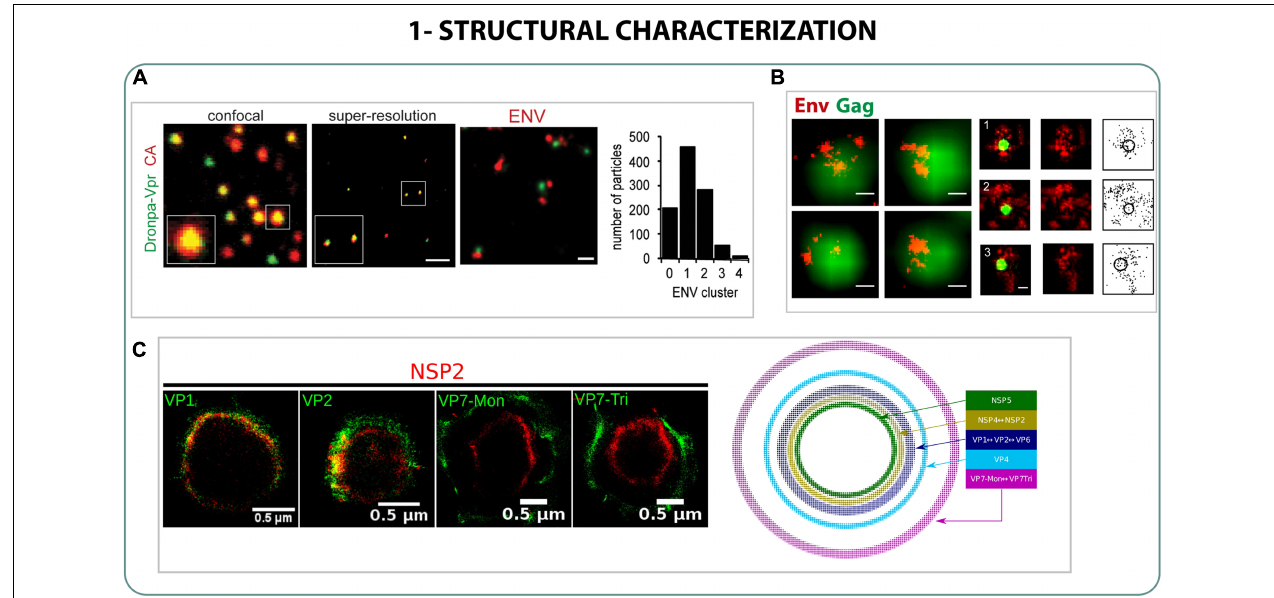
FIGURE 2 | Structural characterization. (A) Dual color PALM/STORM and confocal images of HIV-1 virions labeled with Dronpa-Vpr (green) and CA (red). Scale bar 1 µ m. Right image and graph: Super-resolution image of Env (red) on Dronpa-Vpr particles (green) and quantification of Env clusters on 1,000 HIV-1 particles. Scale bar 200 nm (Lehmann et al., 2011). (B) STORM and PALM on HIV-1 proteins expressed on plasma membrane (right) or on immature HIV-1 particles (left). Green is PALM (Gag) and red is STORM (Env). Scale bar 100 nm (Muranyi et al., 2013). (C) Rotavirus SRM 3B images of different proteins of the viroplasm. Right: model of distribution of viral components (Garcés Suárez et al.,